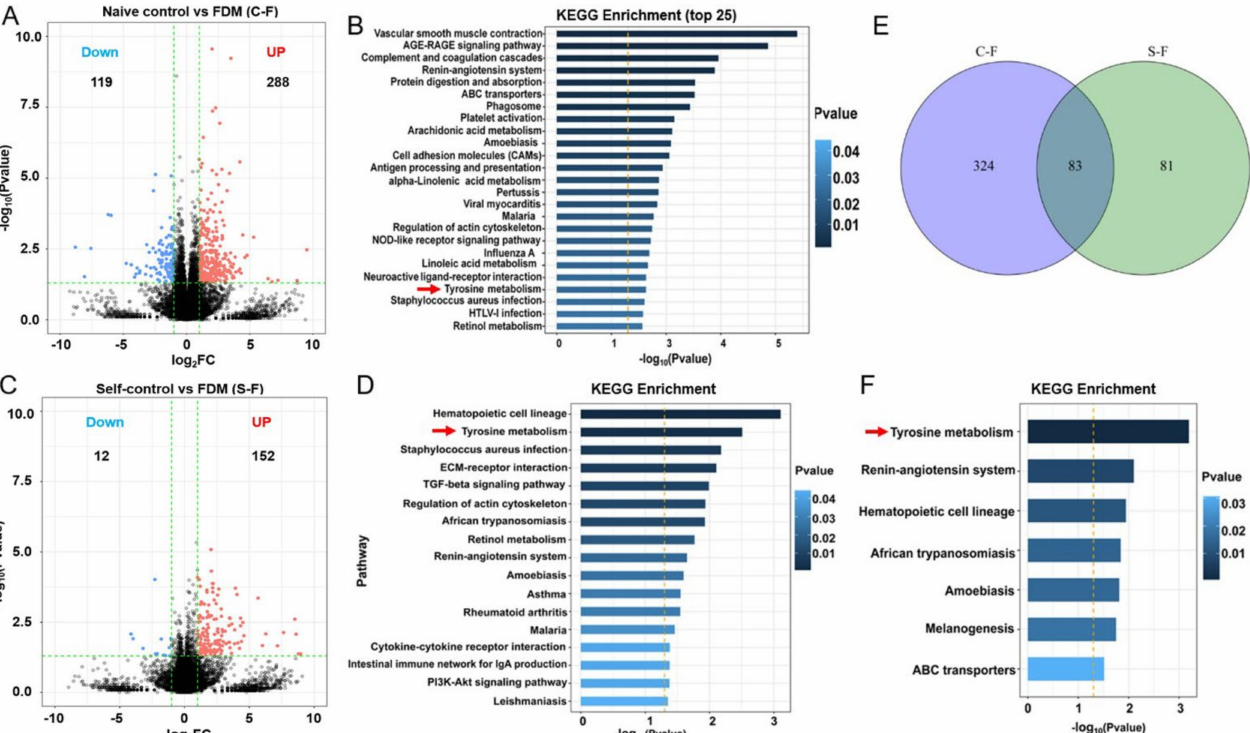
Figure 8. Transcriptional profiling of retinas from form-deprivation-induced myopic (FDM) guinea pigs. ( A ) Volcano plot showing highlights of differentially expressed genes (DEGs) from bulk RNA sequencing of retinas from naïve control and FDM animals. ( B ) The top 25 significantly enriched pathways in the FDM retina (compared to naïve control retina) from the KEGG analysis of the DEGs. ( C ) Volcano plot showing highlights of DEGs from bulk RNA sequencing of retinas from self-control and FDM animals. ( D ) The significantly enriched pathways in the FDM retina (compared to self-control retina) from the KEGG analysis of the DEGs. ( E ) Venn diagram showing the overlapping DEGs between “naïve control vs. FDM” and “self-control vs. FDM”. ( F ) The significantly enriched pathways in the FDM retina from the KEGG analysis of the 83 overlapping genes. Red arrows indicating the tyrosine metabolic pathway in three